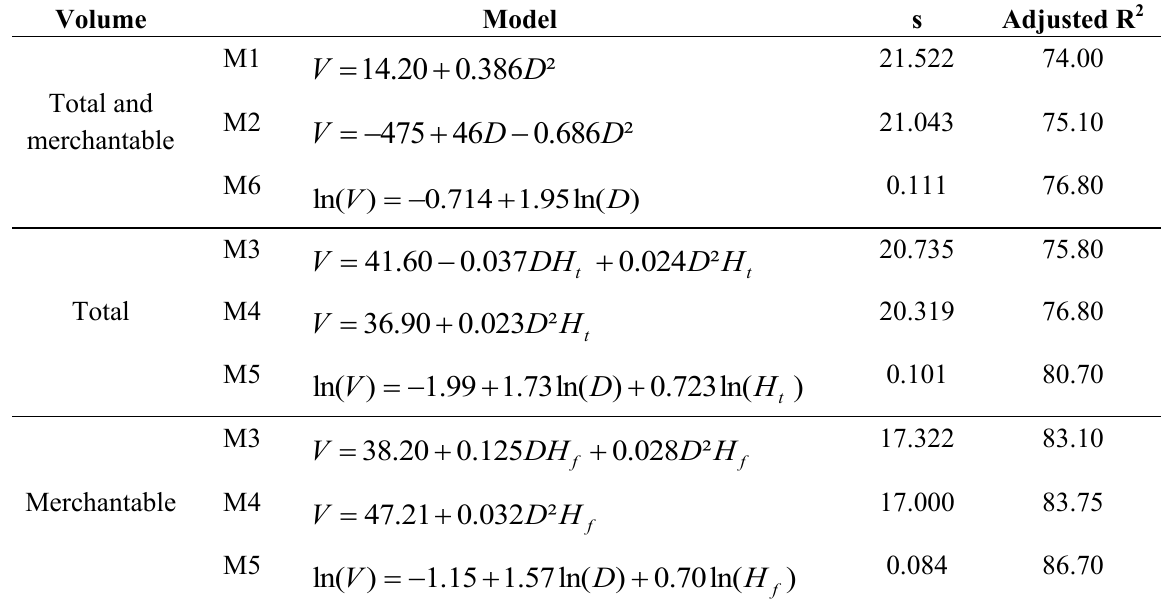
Table 5. Models for estimating the total volume and the merchantable